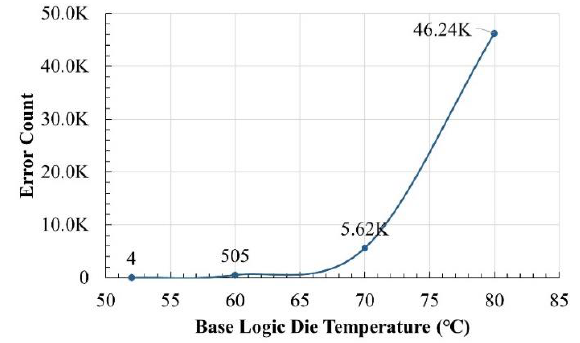
Figure 13. Retention error counts with varying T L for Pseudo channel 0 of Channel 0 at a fixed RCT of 1.28 s.